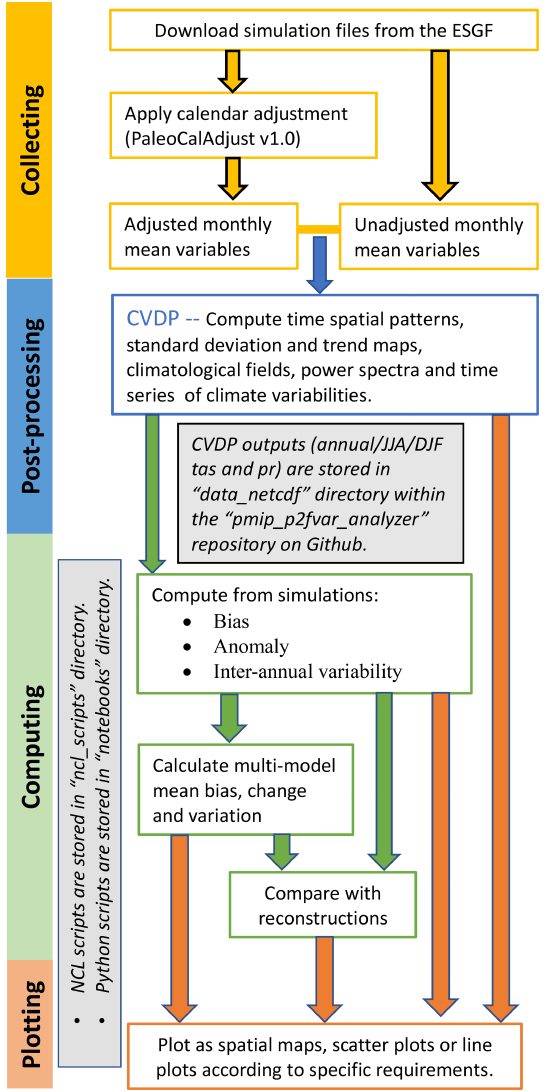
Figure 2. Schematic flowchart illustrating the processes within this